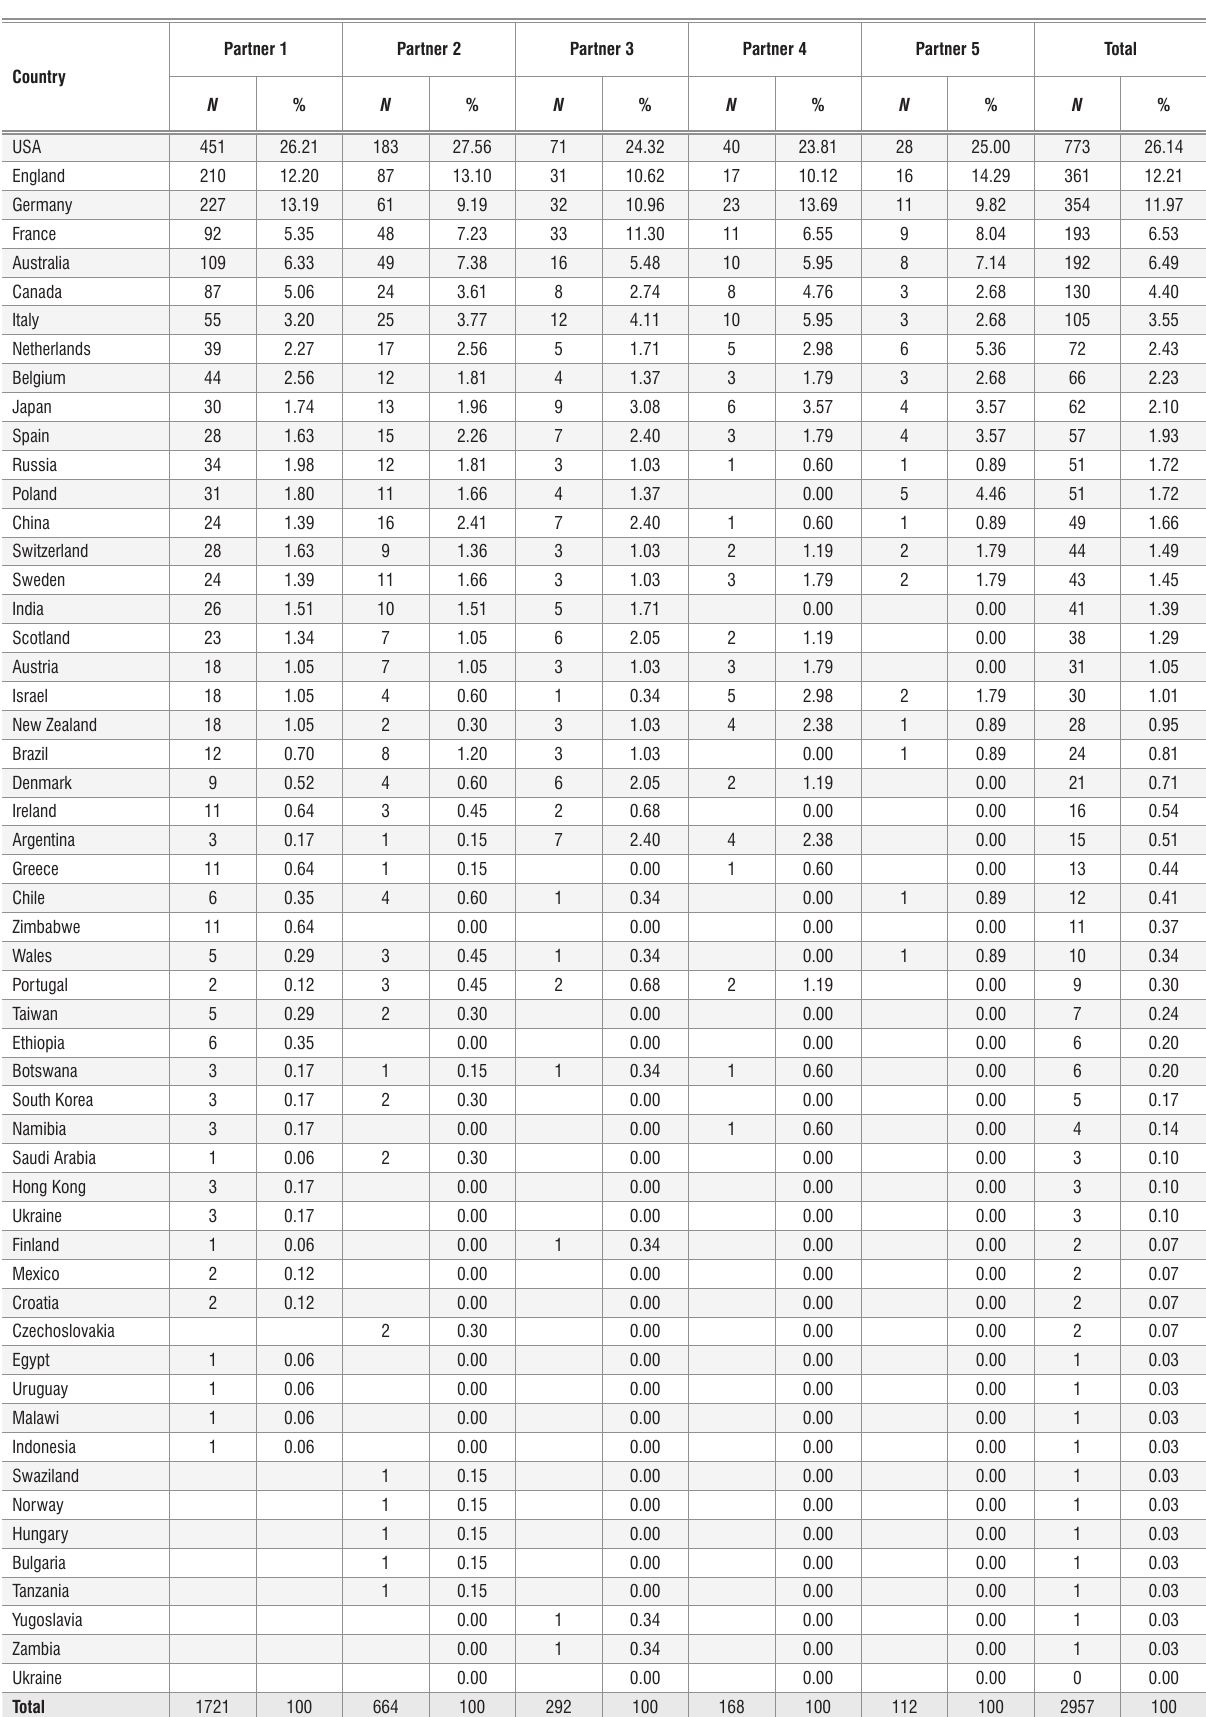
Table 4: Countries of South African partners in natural sciences research, 1975–2005